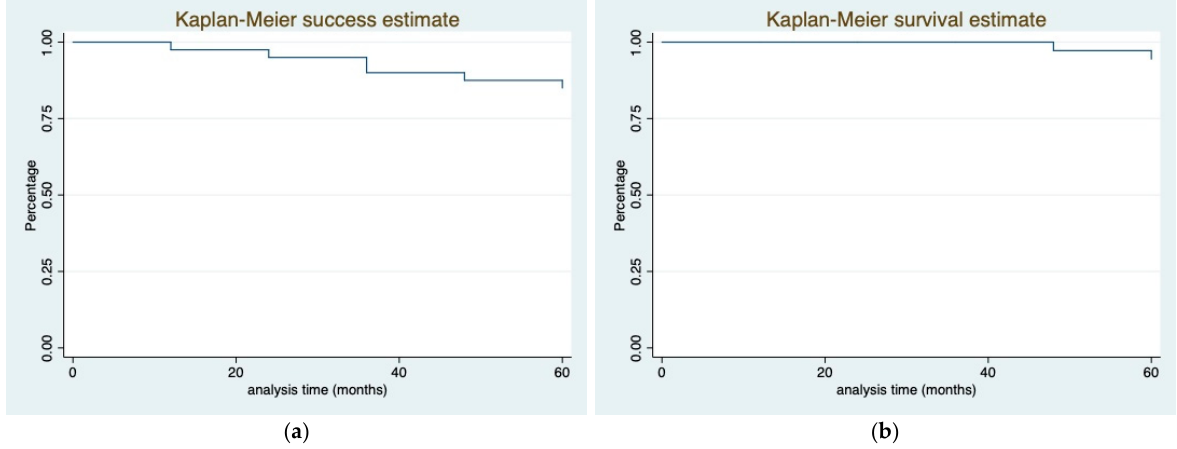
Figure 7. Kaplan–Meier curves plot. ( a ) success plot; ( b ) survival plot.